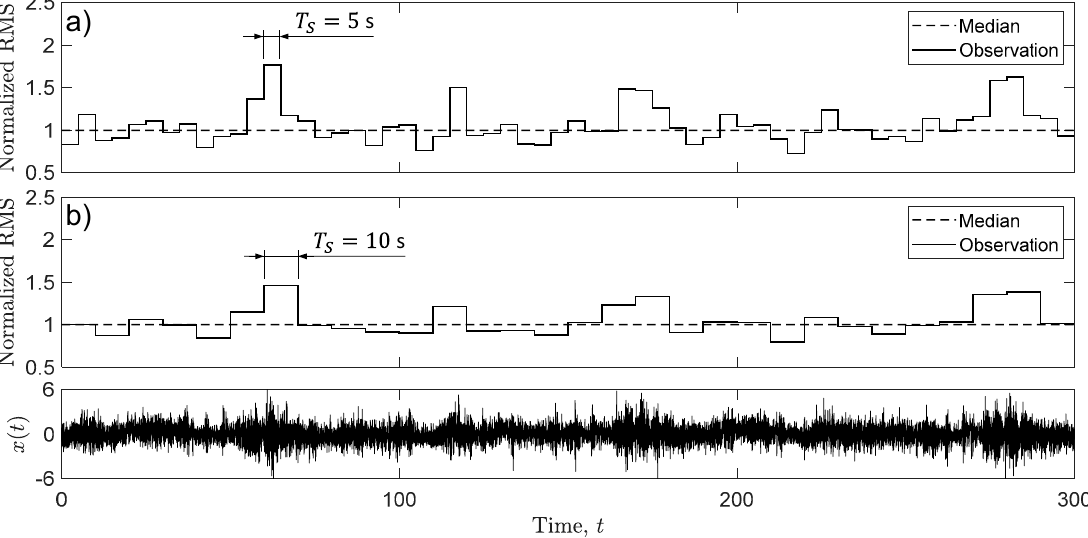
Figure 9. Run test applied to a measured stress-time history classified as stationary: ( a ) T s = 5 s and ( b ) T s = 10 s.